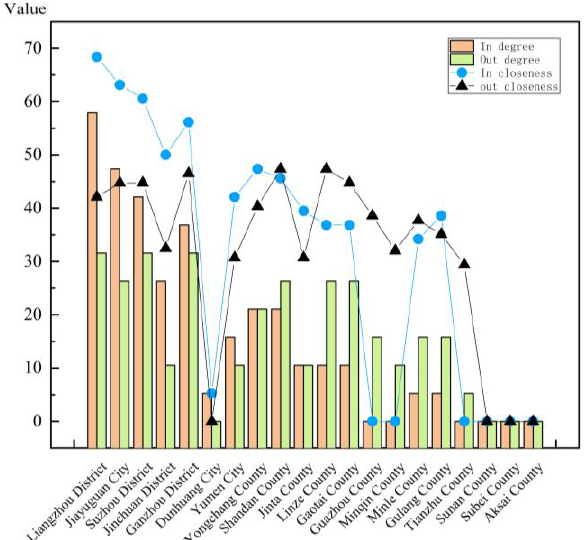
Figure 8. Out- and in-degree of DC and CC of the urban agglomeration in 2020.